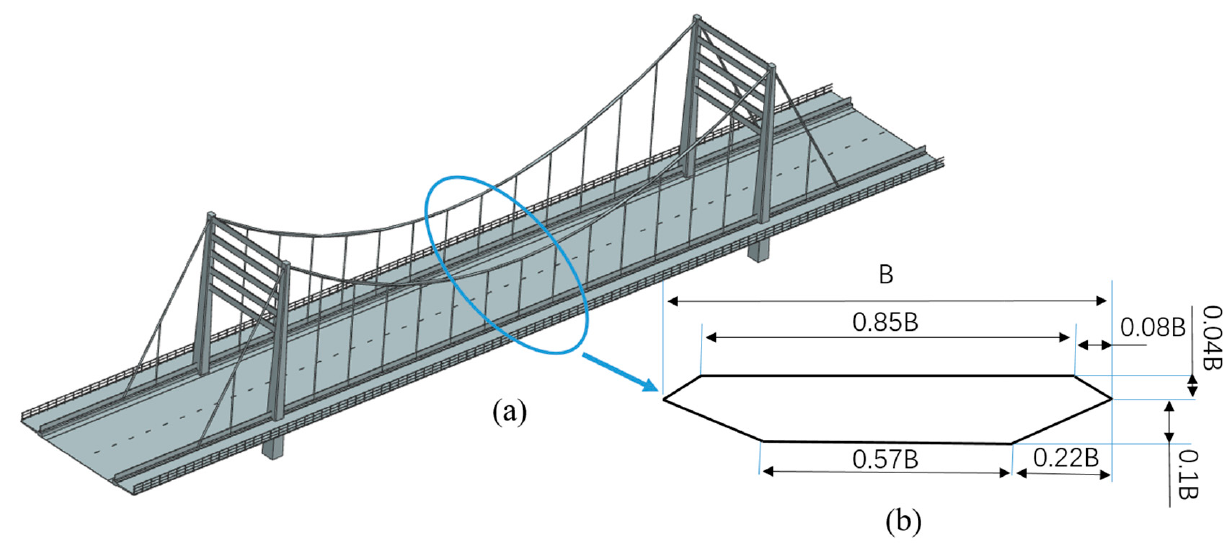
Figure 2. Schematic of bridge and geometric dimensions of bridge deck section: ( a ) Schematic of bridge; ( b ) bridge deck section.